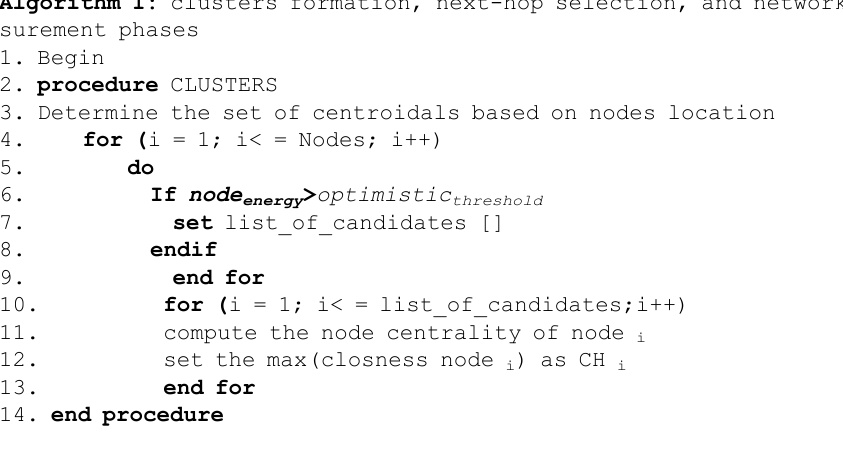
Algorithm 1 governs the phases of proposed RCER protocol. Algorithm 1: clusters formation, next-hop selection, and network mea-